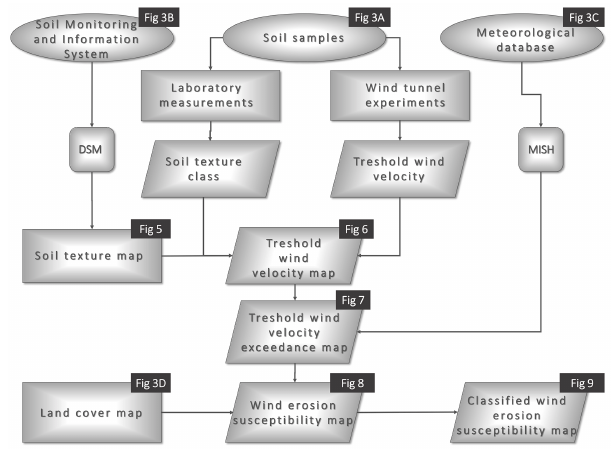
Figure 1. Scheme of the model structure with input layers and the